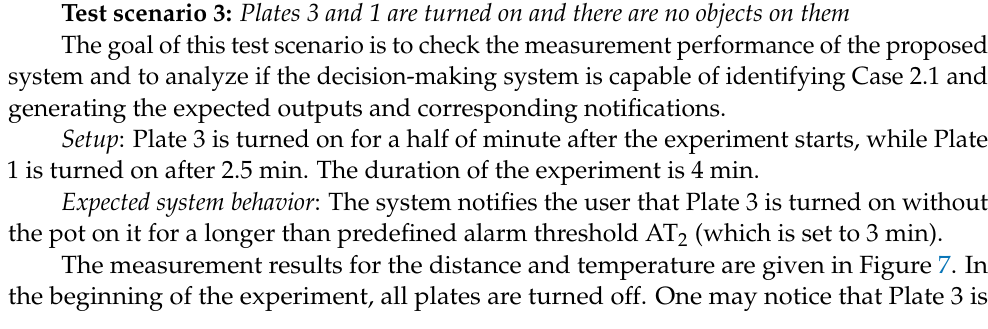
Figure 7. Test results of Scenario 3. Table 5. Analysis of the results for test scenario 2: Plate 1 and Plate 3.